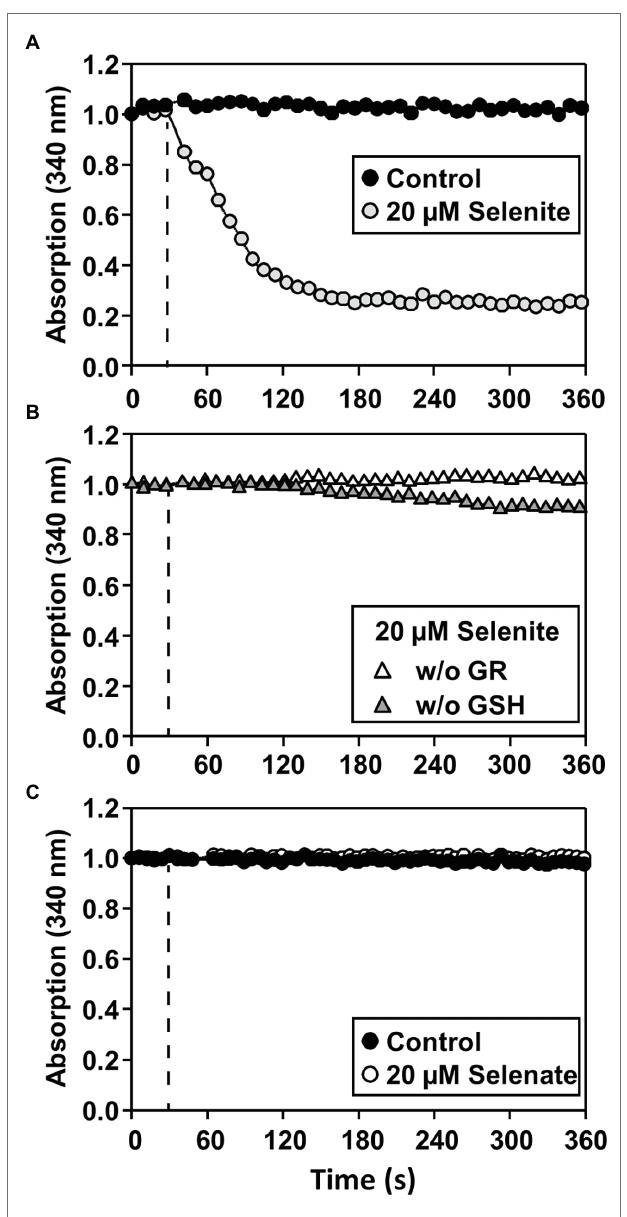
FIGURE 4 | Only selenite can be reduced by GSH in a cell-free system. (A–C) In vitro assay for determining the reduction of selenite (A,B) or selenate (C) by glutathione resulting in glutathione disulfide (GSSG). The assay allows quantification of selenium reduction by coupling the reduction of the byproduct GSSG to GSH by glutathione disulfide reductase (GR) under consumption of NADPH, which can be quantified at 340 nm. (A) The assay (0.5 μ M GR, 2 mM GSH, 100 μ M NADPH) was preincubated at the reaction temperature, and the reaction was started (dashed line) by the addition of 20 μ M selenite (gray circles) or water (Control, black circles). (B) As controls for the specificity of the NADPH-dependent reduction of GSSG by GR, GSH (white triangles) or GR (gray triangles) was omitted from the assay. In contrast to selenite application, (C) application of selenate (white circles) did not result in GSSG formation and was indistinguishable from control (black circles). The selenate assay was performed under the identical conditions described in (A) for selenite. All assays were repeated in triplicates at two individual time points and showed similar